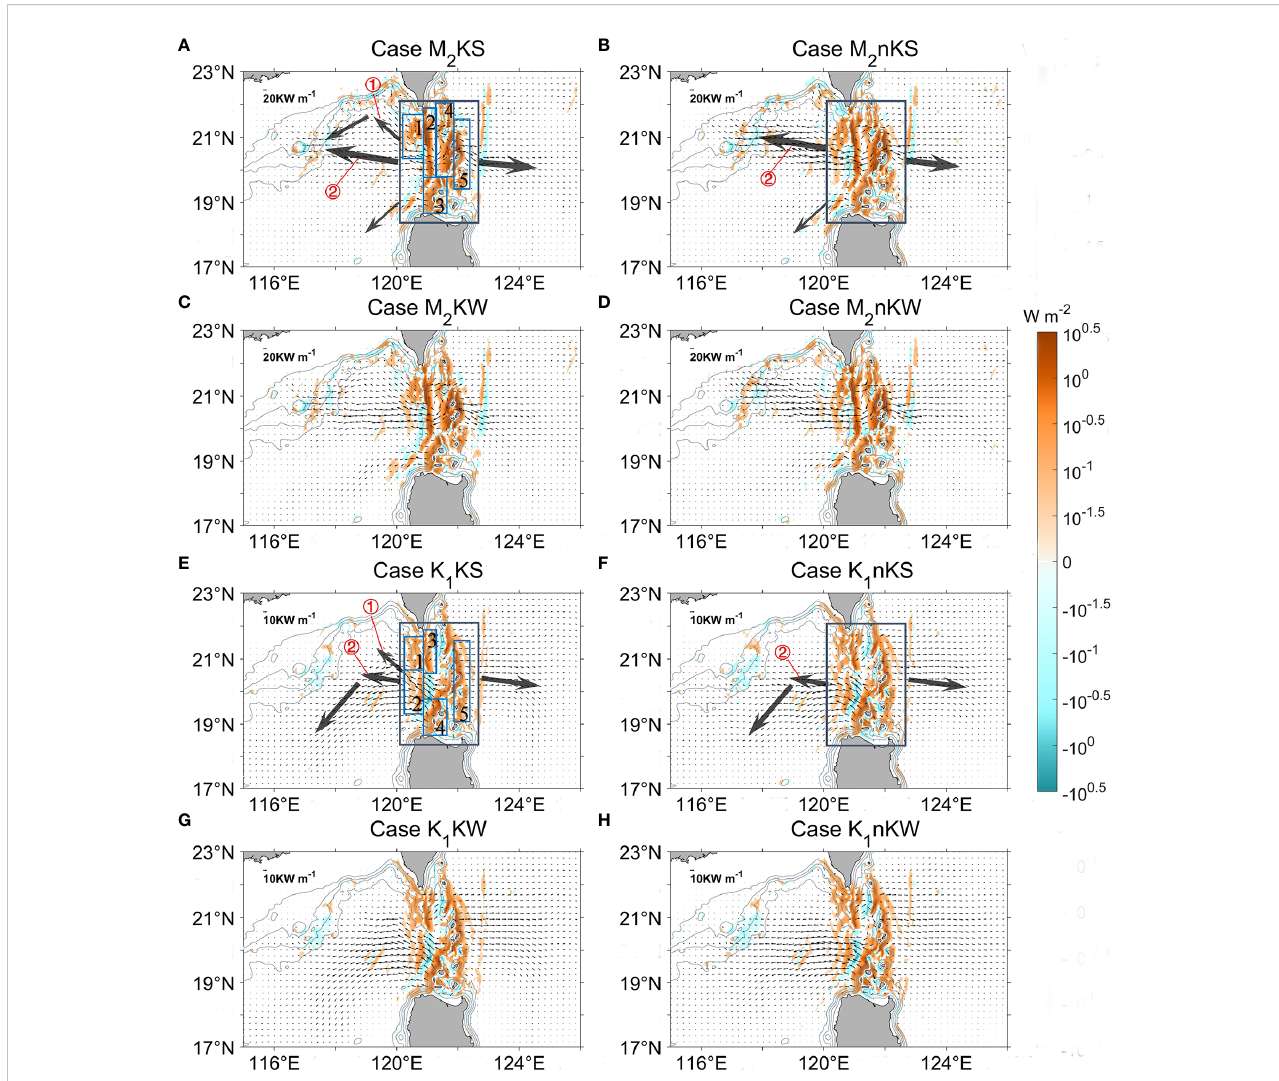
FIGURE 6 Modeled baroclinic energy fl ux (thin black arrows) and conversion rate (color) of the M 2 and K 1 internal tides in the LS and nearby regions. (A – D) For M 2 internal tides. Top row is summer, second row is winter. Left column is the with-Kuroshio cases, right is the without-Kuroshio cases. The gray boxes outline the LS region (120°E - 122.5°E, 18.3° N - 22° N). The blue boxes in the large gray boxes indicate the fi ve M 2 subregions discussed in the main text. The thick black arrows show the main direction of internal tide energy from the source of the LS. Red circles ① and ② represent the northwestward and westward internal tide energy fl ux, respectively. (E – H) The same as (A – D) , but for K 1 internal